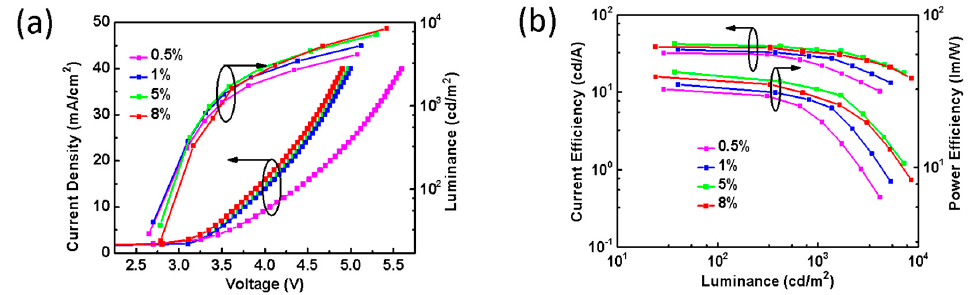
Molecules 2019 , 24 , x 5 of 12 Figure2. ( a )Currentdensity-voltage-luminancecurvesofthedevices. ( b )Currente ffi ciency–luminance– Figure 2. ( a ) Current density ‐ voltage ‐ luminance curves of the devices. ( b ) Current efficiency– power e ffi ciency characteristics. luminance–power efficiency characteristics.